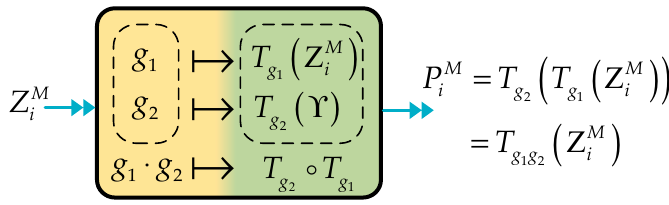
(cid:12) Z and M . Figure 7. Illustration of the transformation between (cid:12) (cid:12) Z M (cid:12) and P M i . i i i P